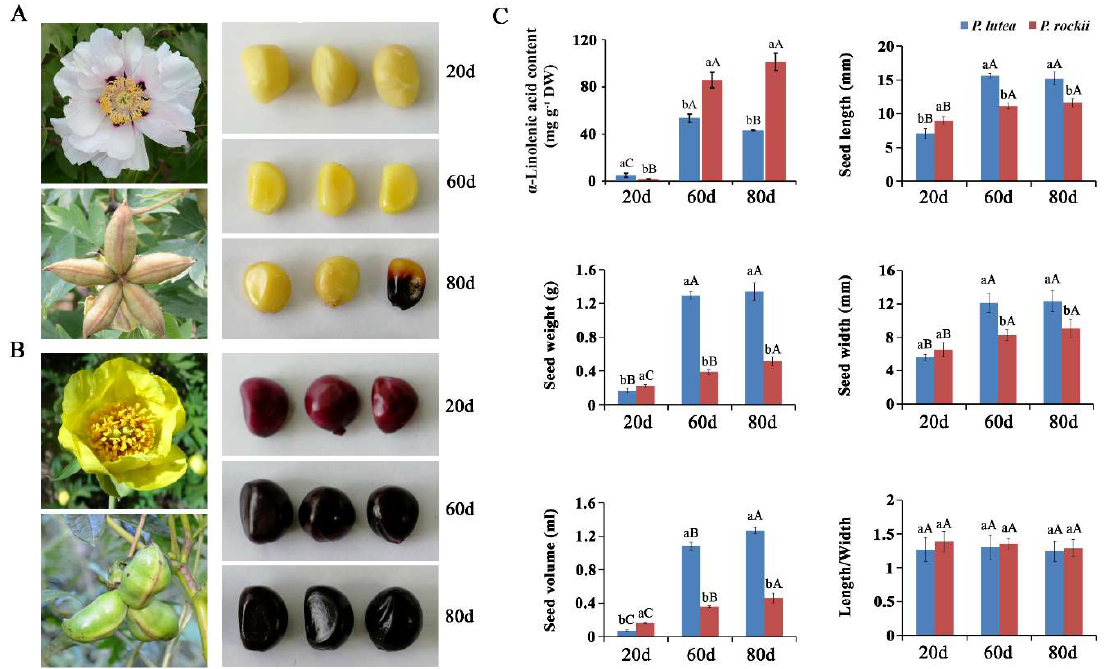
Figure 1. Phenotypic variation between the two tree peony species. ( A ) The flower, fruit and developing seeds of P. rockii and ( B ) P. lutea; ( C ) seed variation analysis. Different small letters indicate significant differences between the species at the same time point at p < 0.05 level, as determined by the least significant differences test. Different capital letters indicate significant differences among different time points for the same